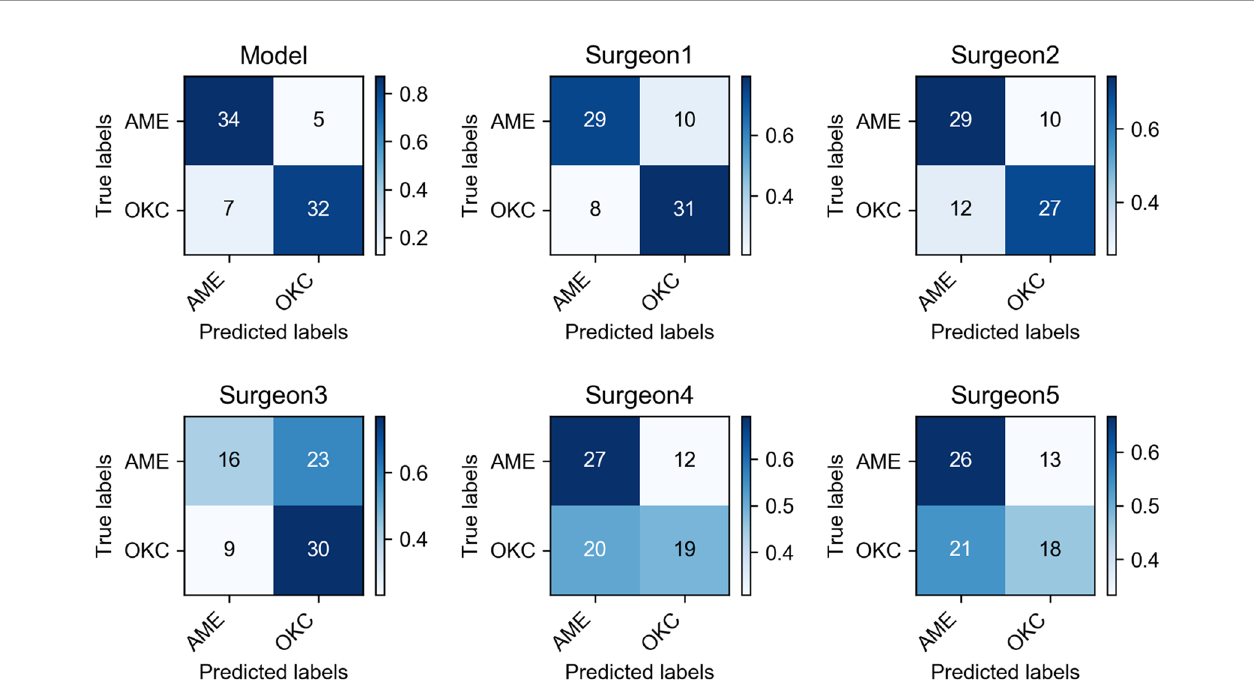
FIGURE 6 | Confusion matrices of Inception v3 and fi ve oral and maxillofacial surgeons showed the speci fi c diagnostic performance. The color shade of the grid represented the proportion of each